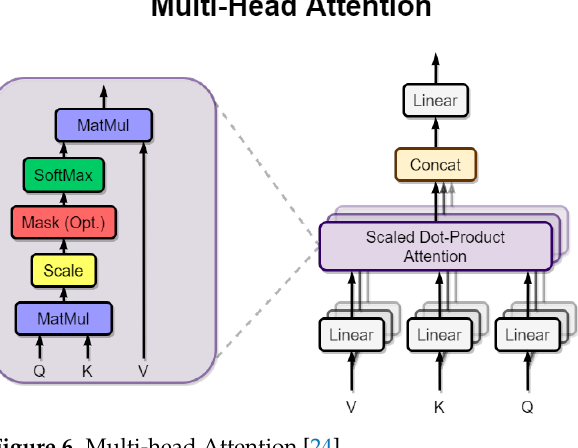
Figure 6. Multi-head Attention